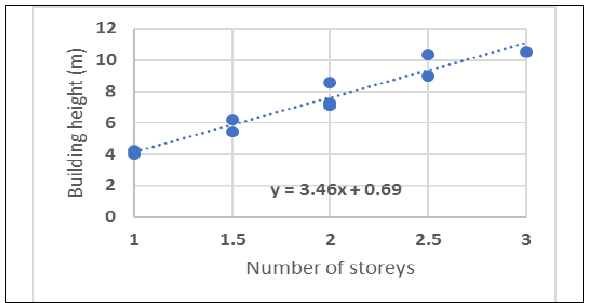
Figure 2. Relation between the number of storeys and the height of the buildings, number of storeys for some buildings are given to be 1.5 or 2.5 in the case if the Hight of the building is higher than